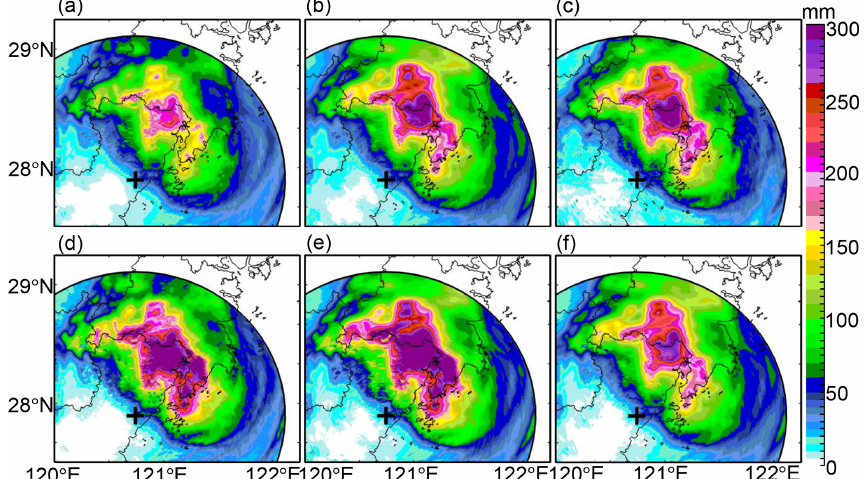
), (b) R ( Z C ), (c) R ( K DP ), (d) R ( Z M H H